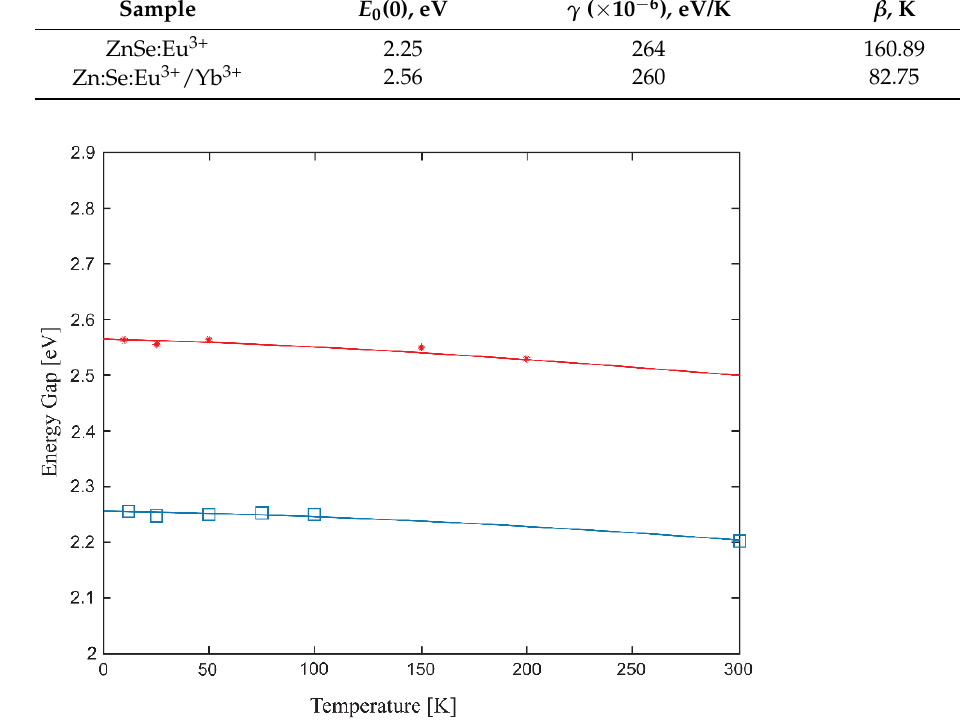
Figure 4. Energy band gap variation as a function of temperature for ZnSe:Eu 3+ (green squares) and ZnSe:Eu 3+ /Yb 3+ (red dots). The line represents a theoretical fitting with Equation (2).